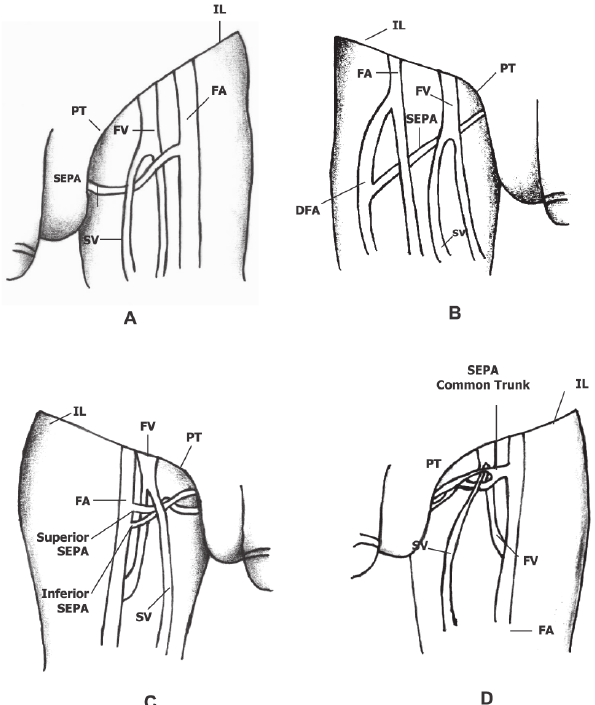
Figure 1 - Types of distribution of the superficial external pudendal artery (SEPA). A) single artery; B) artery originating at the deep femoral artery; C) artery with double origin; D) artery with a common trunk; FA, femoral artery; FV, femoral vein; SV, saphenous vein; PT, pubic tubercle; IL, inguinal ligament; DFA, deep femoral